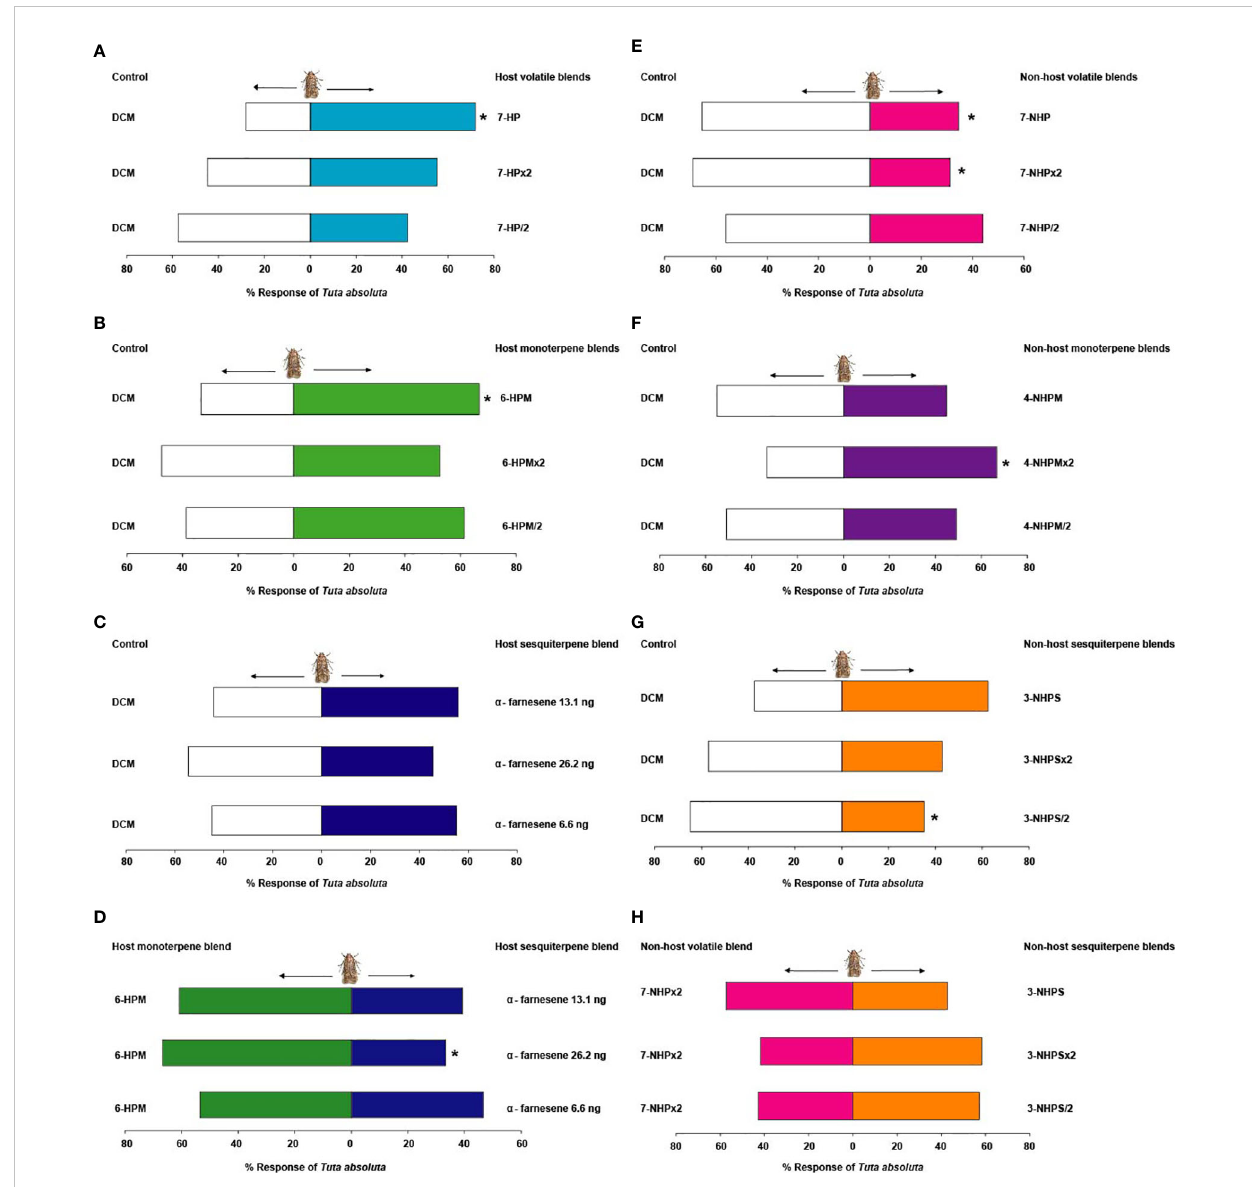
FIGURE 4 Behavioural response of Tuta absoluta females to the most discriminating synthetic (A) seven-component host plant volatile blend, (B) six- component host plant monoterpene blend, (C) host plant sesquiterpene (E, E)- a -farnesene, (D) most attractive six-component blend of the host plant monoterpenes relative to host plant sesquiterpenes, (E) seven-component non-host plant volatile blend, (F) four-component non-host plant monoterpene blend, (G) three-component non-host plant sesquiterpene blend, and (H) most effective seven-component blend of the non-host plants relative to non-host plant sesquiterpenes. Asterisk (*) indicates signi fi cant differences (Chi-square test: P =